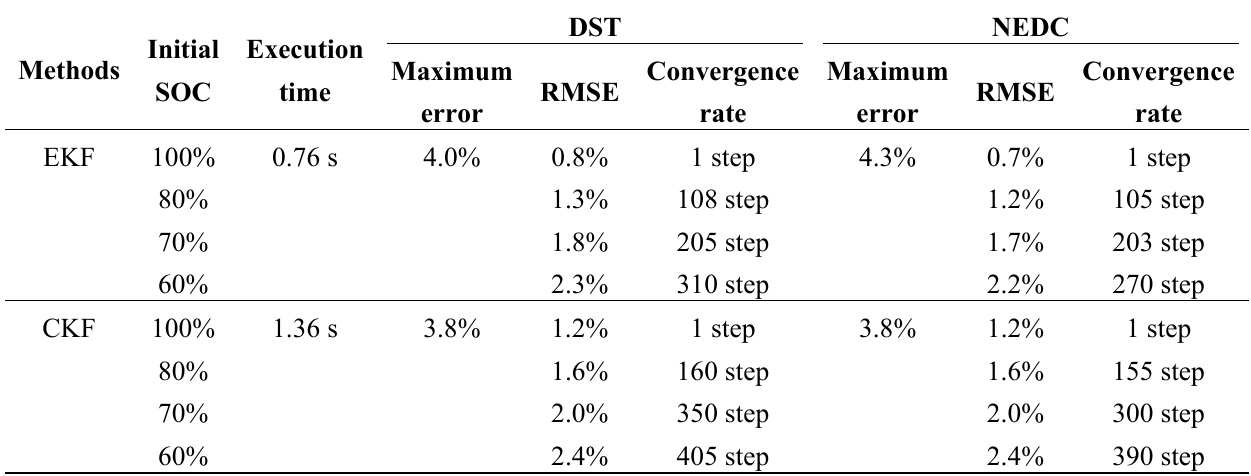
Table 2. Comparison of SOC estimation without measurement